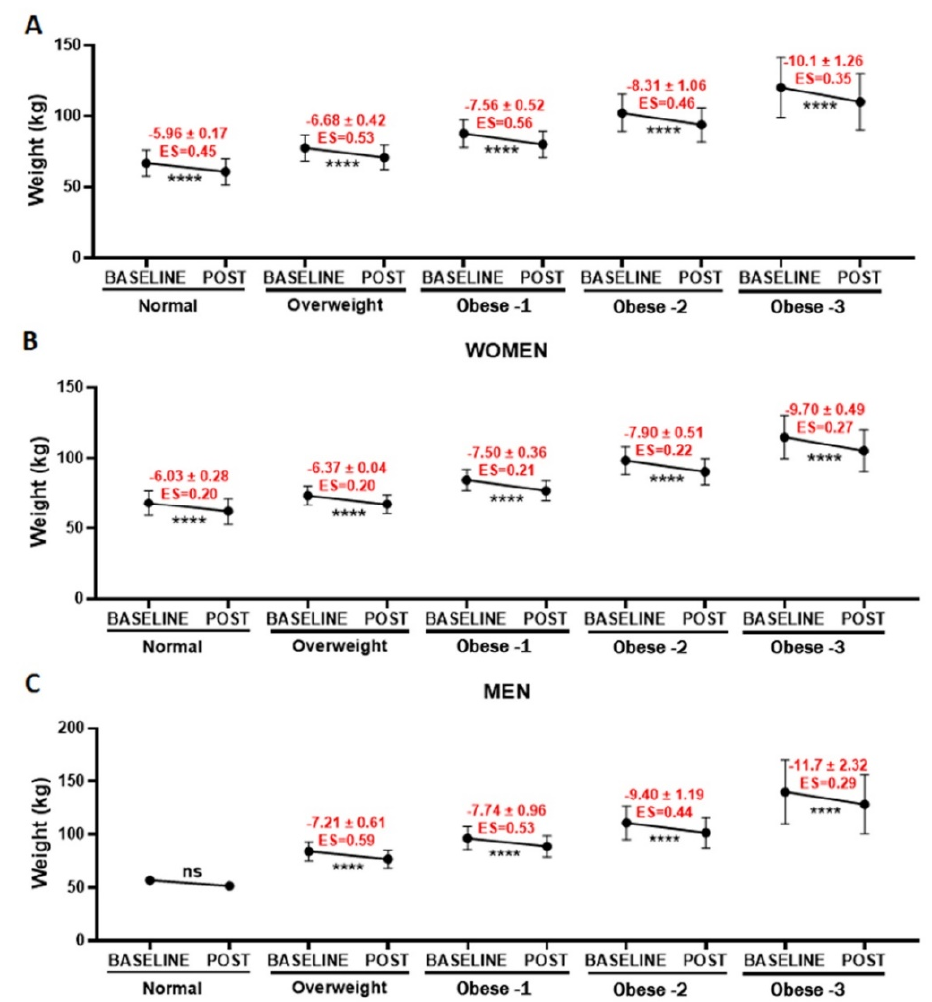
Figure 5. Representation of variation in weight (kg), presented as the mean and SD, of all the volunteers enrolled in the present study ( A ) or separated into women ( B ) and men ( C ), followed by separation by different BMI (normal—18.6–24.9 kg/m 2 ; overweight—25 to 29.9 kg/m 2 ; obese I—>30 kg/m 2 ; obese II—35 and 39.9 kg/m 2 ; and obese III—40 kg/m 2 ), both before (BASELINE) and after (POST) 4 Phases Methodology application. **** p < 0.0001.